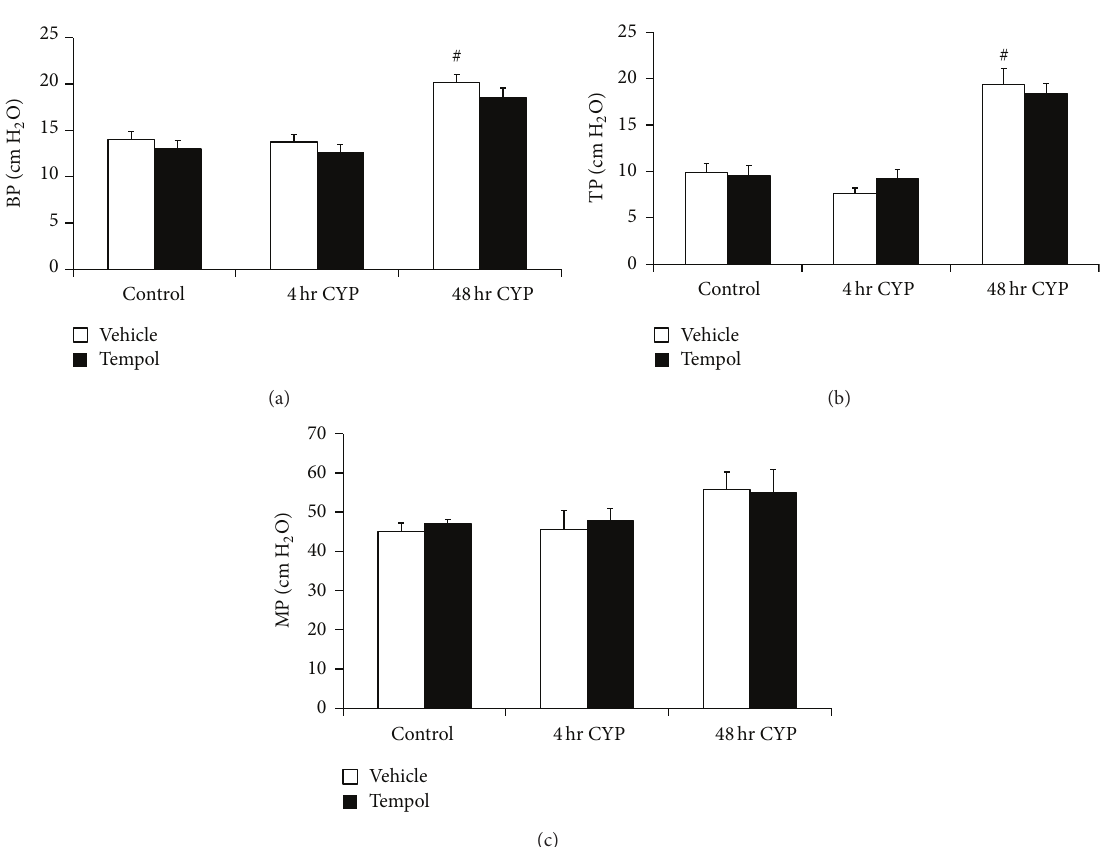
Figure 6: Tempol in the drinking water was without effect on baseline pressure ((a); BP), threshold pressure ((b); TP), or peak micturition pressure ((c); MP; cm H 2 O) in control or CYP-treated (4hr; 48 hr) rats. Sample sizes are 𝑛 = 6 in control and treatment groups. # 𝑃 ≤ 0.01 compared to control + vehicle (between-group